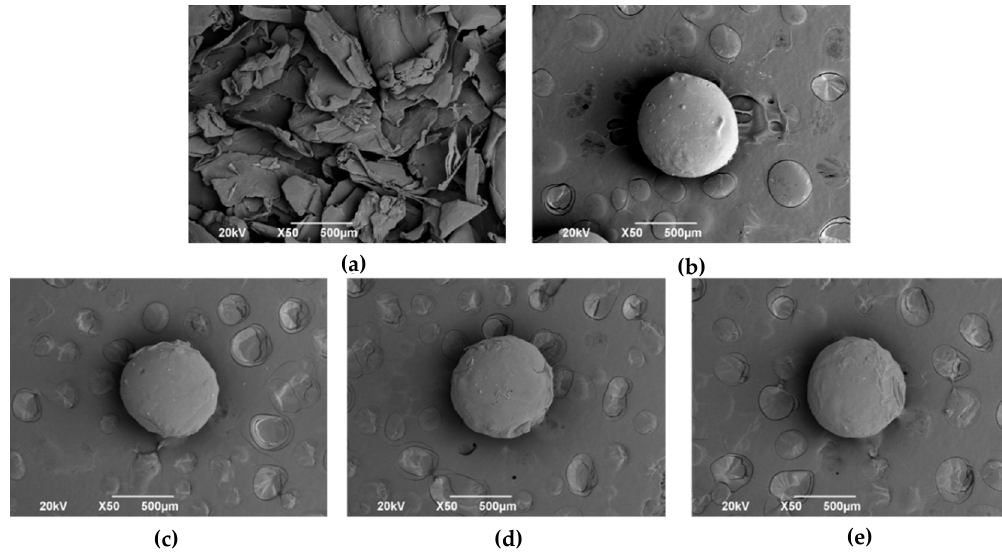
Figure 5. SEM micrographs at 50 × of: ( a ) CS flakes ( b – e ) CS spheres [16].